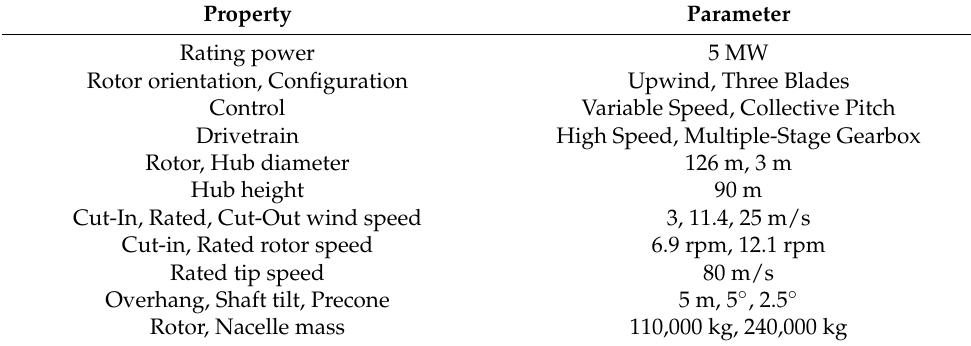
Table 5. Main properties of the NREL offshore 5 MW wind turbine.